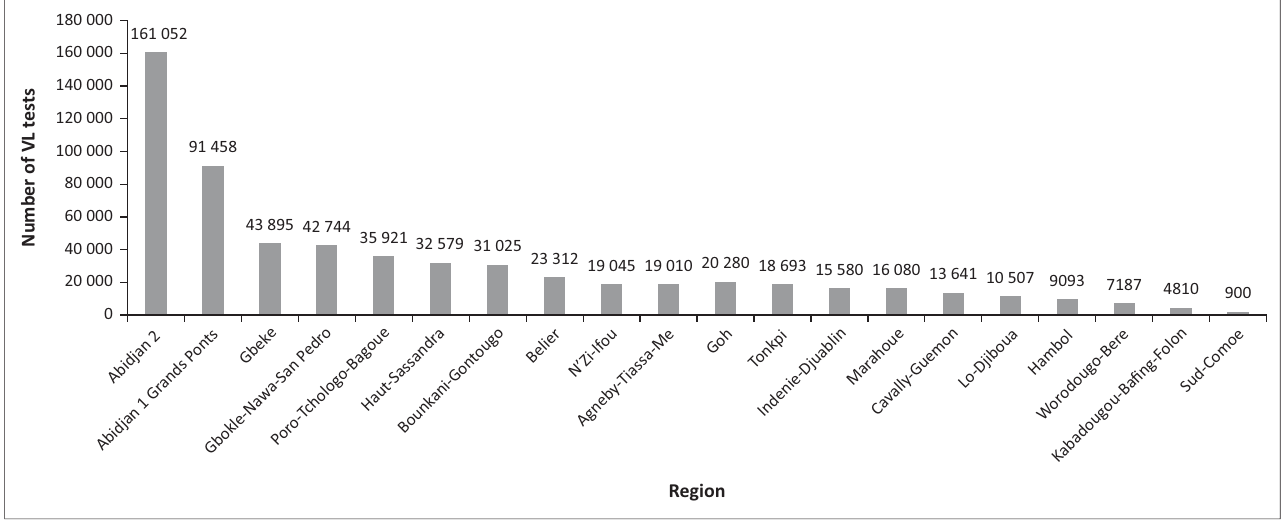
FIGURE 1: Number of viral load tests in Côte d’Ivoire by region, October – December 2019. The 20 regions of the country are covered by 17 public laboratories that are capable of molecular testing for HIV viral load. The capital Abidjan is divided into two jurisdictions based on geospatial parameters with the most people living with HIV located in Abidjan 2. This graph was produced directly from the viral load dashboard.